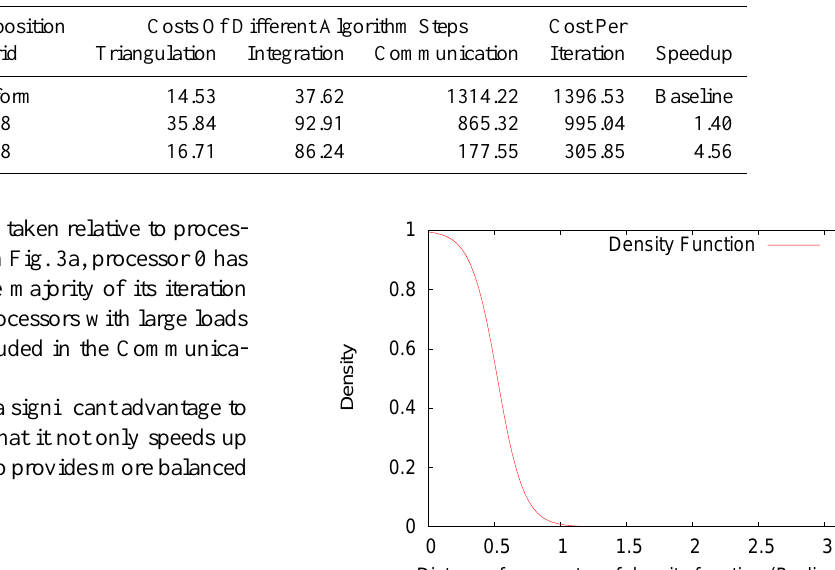
Table 4. Timings based on sorting approach used. Uniform uses a coarse quasi-uniform SCVT to define region centres and their associated radii and sorts using maximum distance between centres and neighbouring centres. × 8 uses a coarse SCVT with a 8 to 1 ratio in grid sizes to effect the same type of sorting. Voronoi uses the same × 8 coarse SCVT grid to define regions centres and sorts using the neighbouring Voronoi cell-based sort.